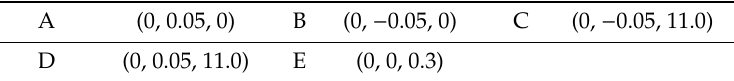
Table 1. Basic coordinates of the mathematical model (unit: m).